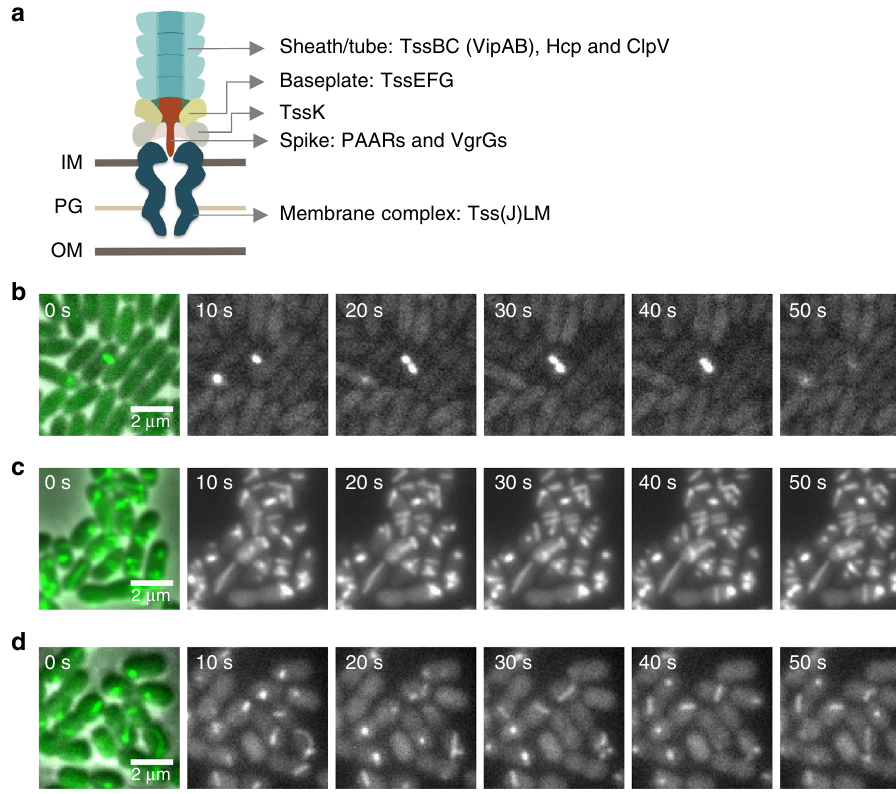
Fig. 1 The various T6SS dynamics in different bacteria. a The overall structure of T6SS adapted from Nazarov et. al. 14 . b Time-lapse imaging of H1-T6SS dynamics in cells of P . aeruginosa PAO1 ( Δ retS background). The most left panel shows a merged image of phase contrast and GFP channel (ClpV-GFP); the other panels show the time-lapse series of GFP channel (ClpV-GFP) in an interval of 10 s. c Time-lapse imaging of T6SS dynamics in cells of V . cholerae 2740-80. The most left panel shows a merged image of phase contrast and GFP channel (TssB-msfGFP); the other panels show the time-lapse series of GFP channel (TssB-msfGFP) in an interval of 10 s. d Time-lapse imaging of T6SS dynamics in cells of A . baylyi ADP1. The most left panel shows a merged image of phase contrast and GFP channel (TssB-sfGFP); the other panels show the time-lapse series of GFP channel (TssB-sfGFP) in an interval of 10 s. Scale bar: 2 µ